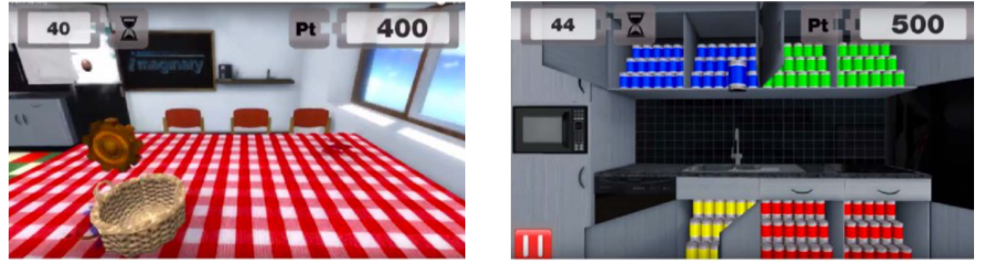
Fig. 3. Two-dimensional Environments in games from the Rehab@Home system (Jonsdottir et al.,